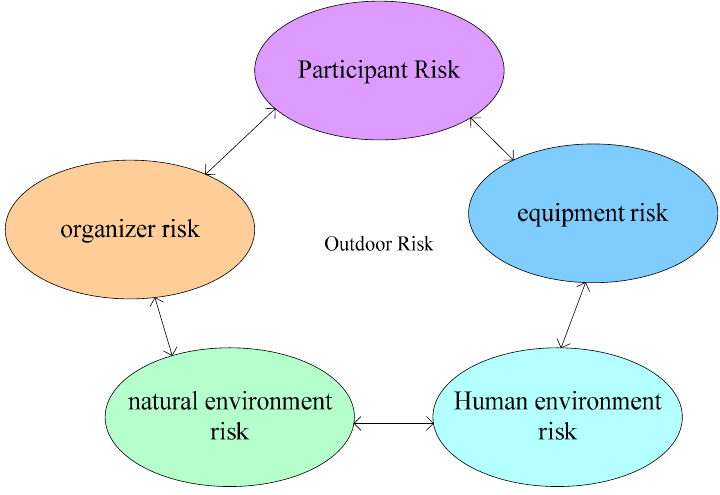
Figure 1. Influencing factors of outdoor sports risks and safety accidents.